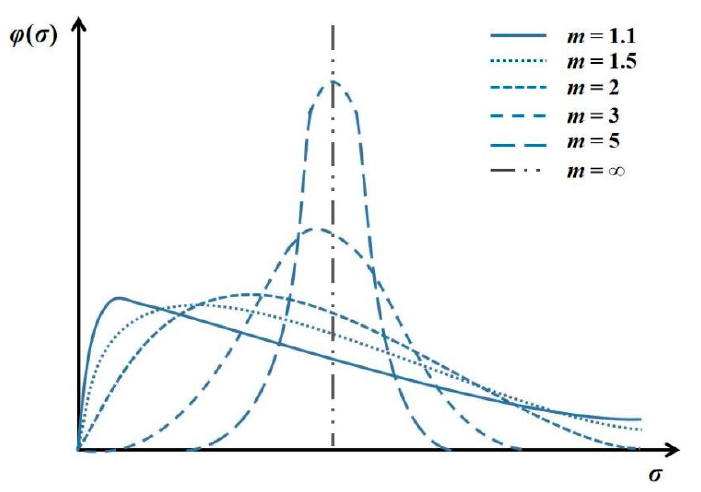
Figure 1. Mechanical property distribution for five various homogeneous specimens (both strength and elastic modulus follow the same distribution).